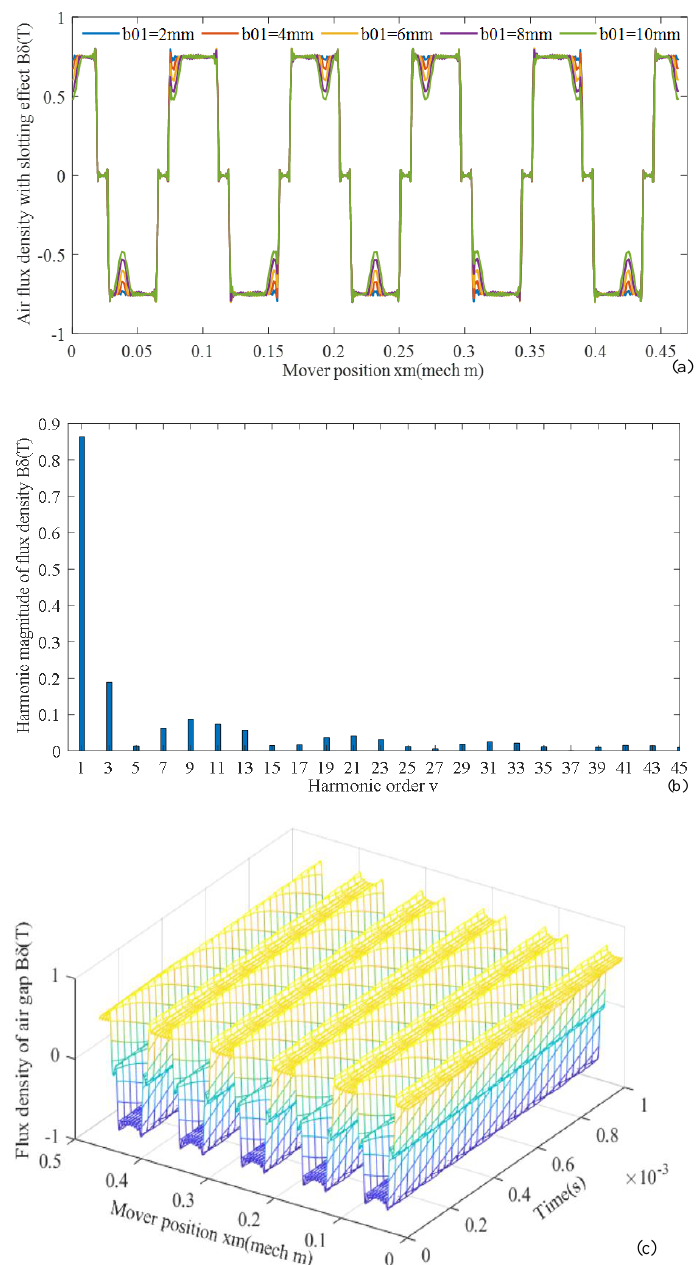
Figure 19. Air gap flux density ( a ) changing with slotting opening width b 01 , ( b ) FFT, ( c ) changing with space and time.